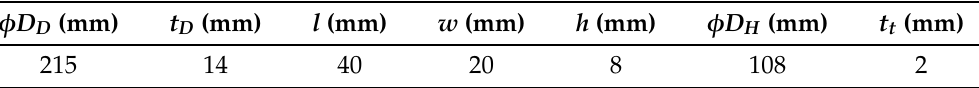
Table 2. Basic dimensions of pad-on-disc system components: φ D D —disc diameter, t D —disc